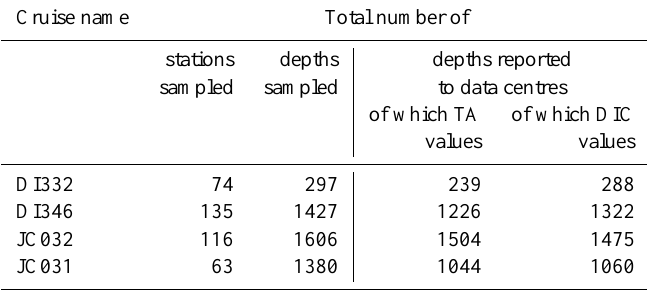
Table 3. Total number of (i) stations sampled, (ii) depths sampled, (iii) DIC and TA samples left after first- and second-level quality control for each